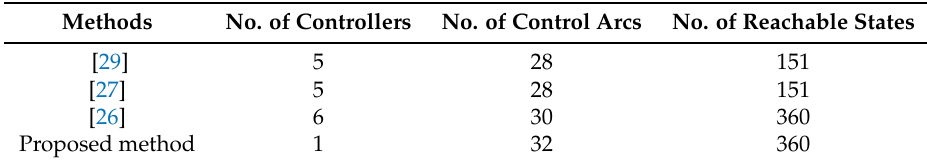
Table 3. Performance comparison of the proposed method with some of the available methods in the literature.